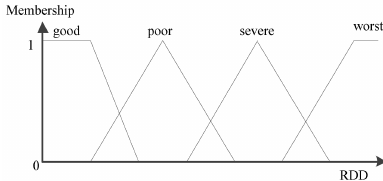
Figure 3. Function of power transformer operating state and relative degree of degradation